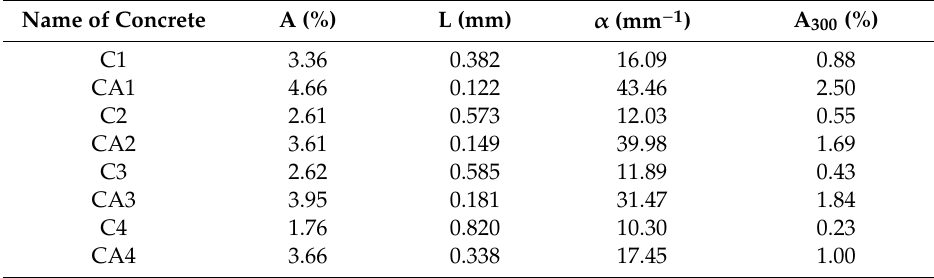
Table 8. The air void parameter